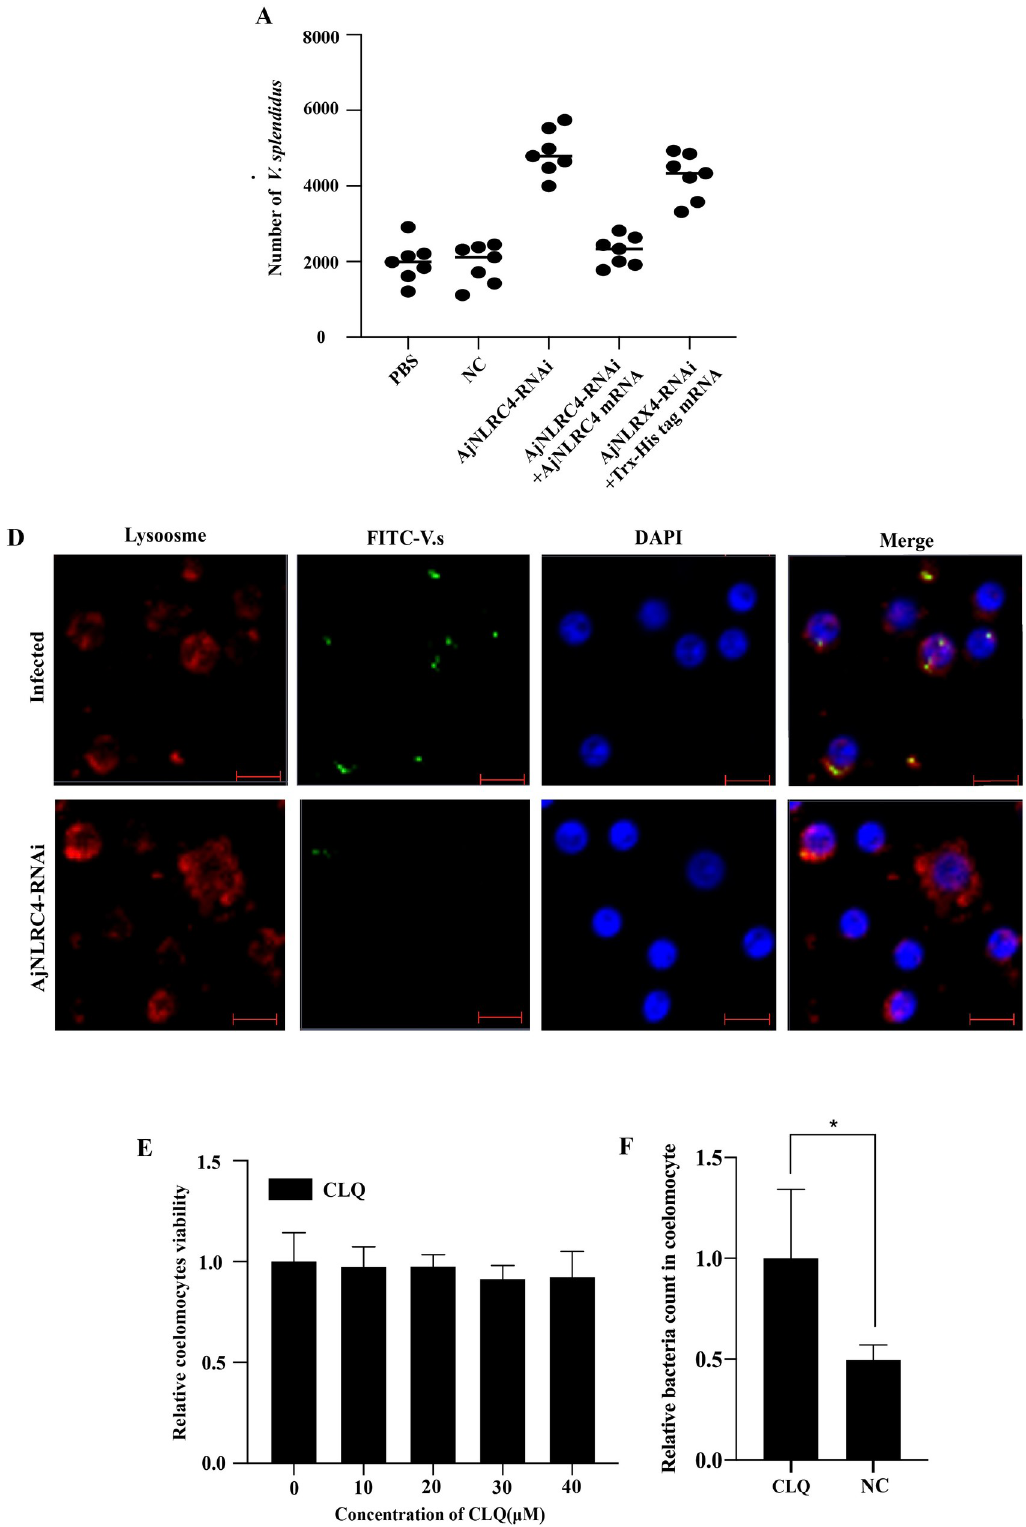
Fig 9. Endocytosed V . splendidus is further cleared via lysosome degradation. (A) Analysis of the V . splendidus clearance ability of AjNLRC4. Each dot represents a group. The horizontal bars represent the medians. (B) Colocalization of ingested V